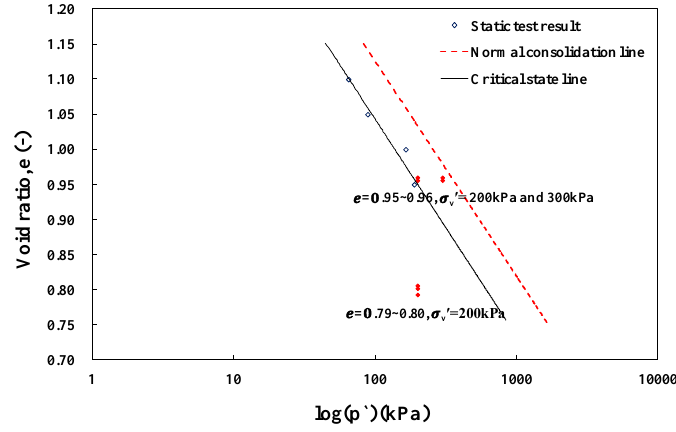
Figure 7. Critical state line (CSL) (adapted from [21]).